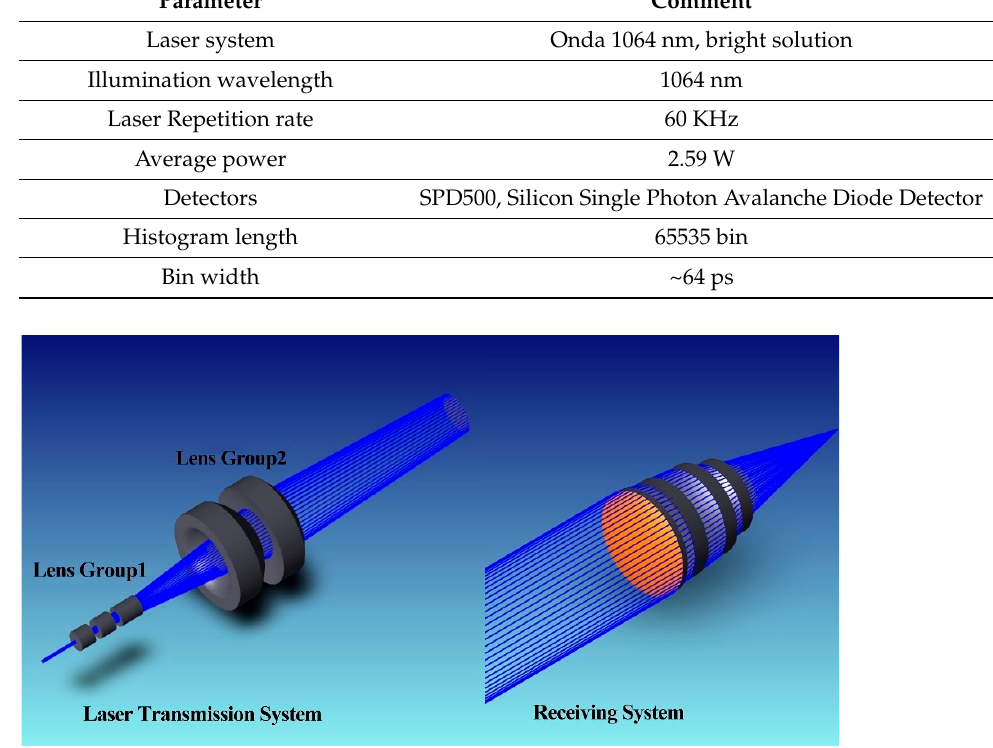
Figure 2. Laser transmission and receiving